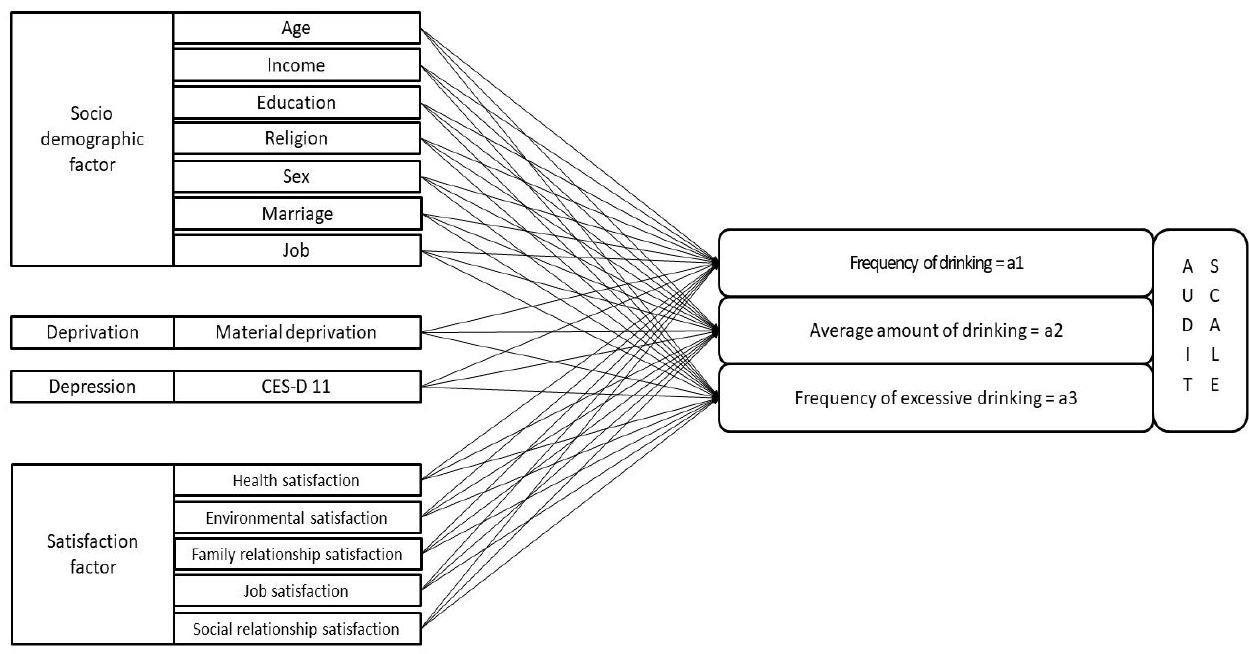
Figure 1. Research Framework.